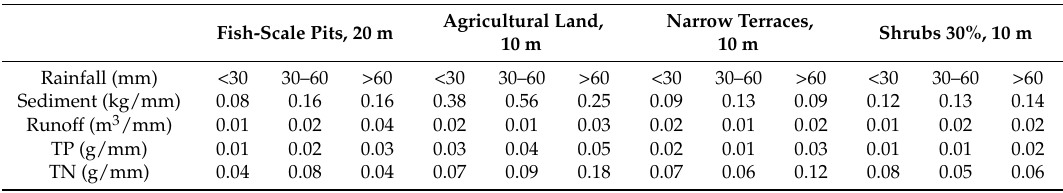
Table 3. Sediment, runoff, TN loss and TP loss under different rainfall ranges in respective